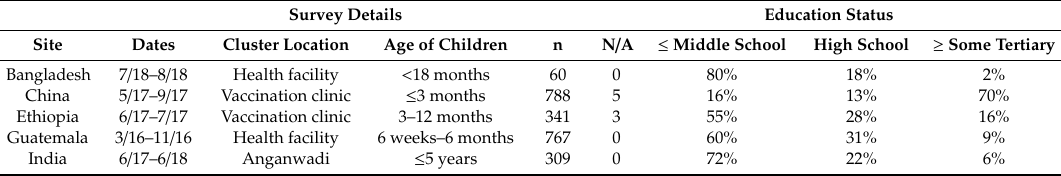
Table 1. Survey details and educational attainment by